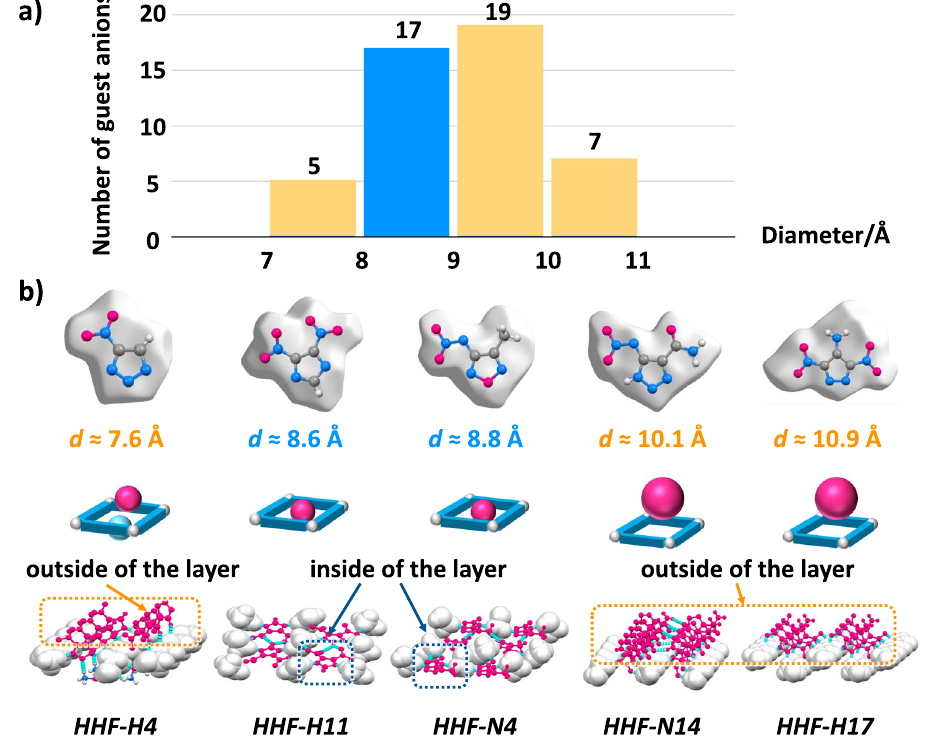
Fig. 8 | The further application of the size matching strategy. a The predicted diameter for N-rich azole anion (48 hits). b Layer assembly mode of HHF-H4, HHF- H11, HHF-N4,HHF-N14, HHF-H17, and crystal packing diagram (Red ballsrepresent